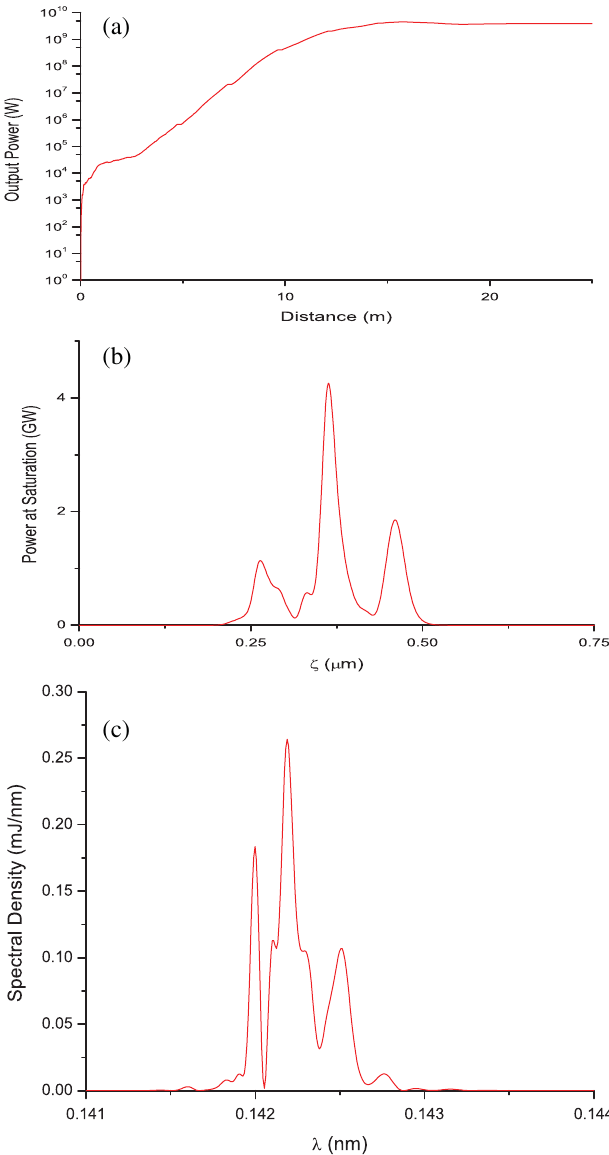
sponding to 2 (cid:6) 10 9 1.42 A˚ photons in less than 0.5 fs FWHM.